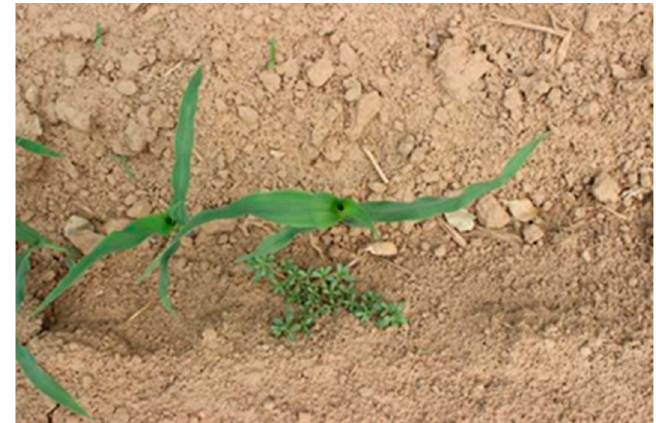
Figure 2. Images taken on sunny days.